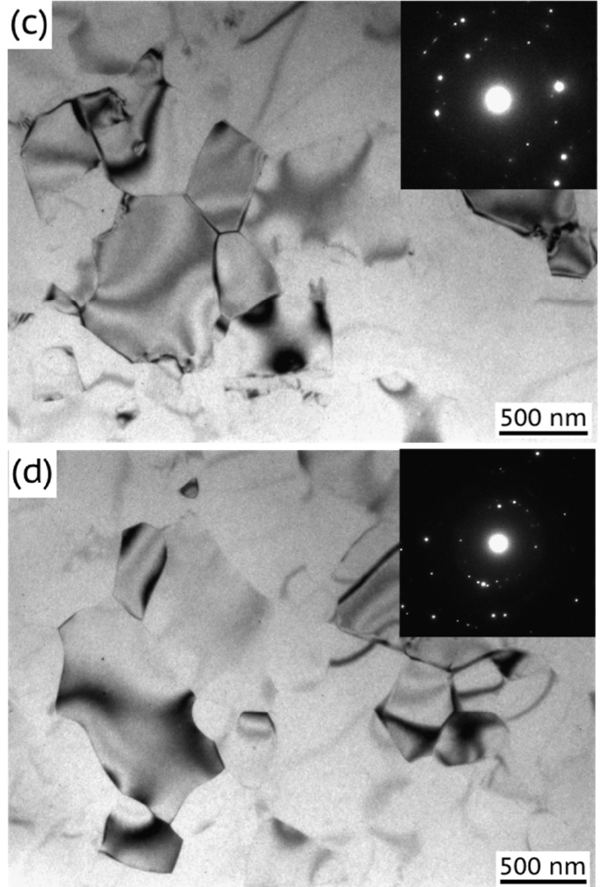
Figure 2. The microstructure of the Al–0.4Zr alloy subjected to HPT ( a ), subsequent annealing ( b ), and annealing and additional deformation by HPT to 0.25 ( c ) and 0.75 revolutions ( d